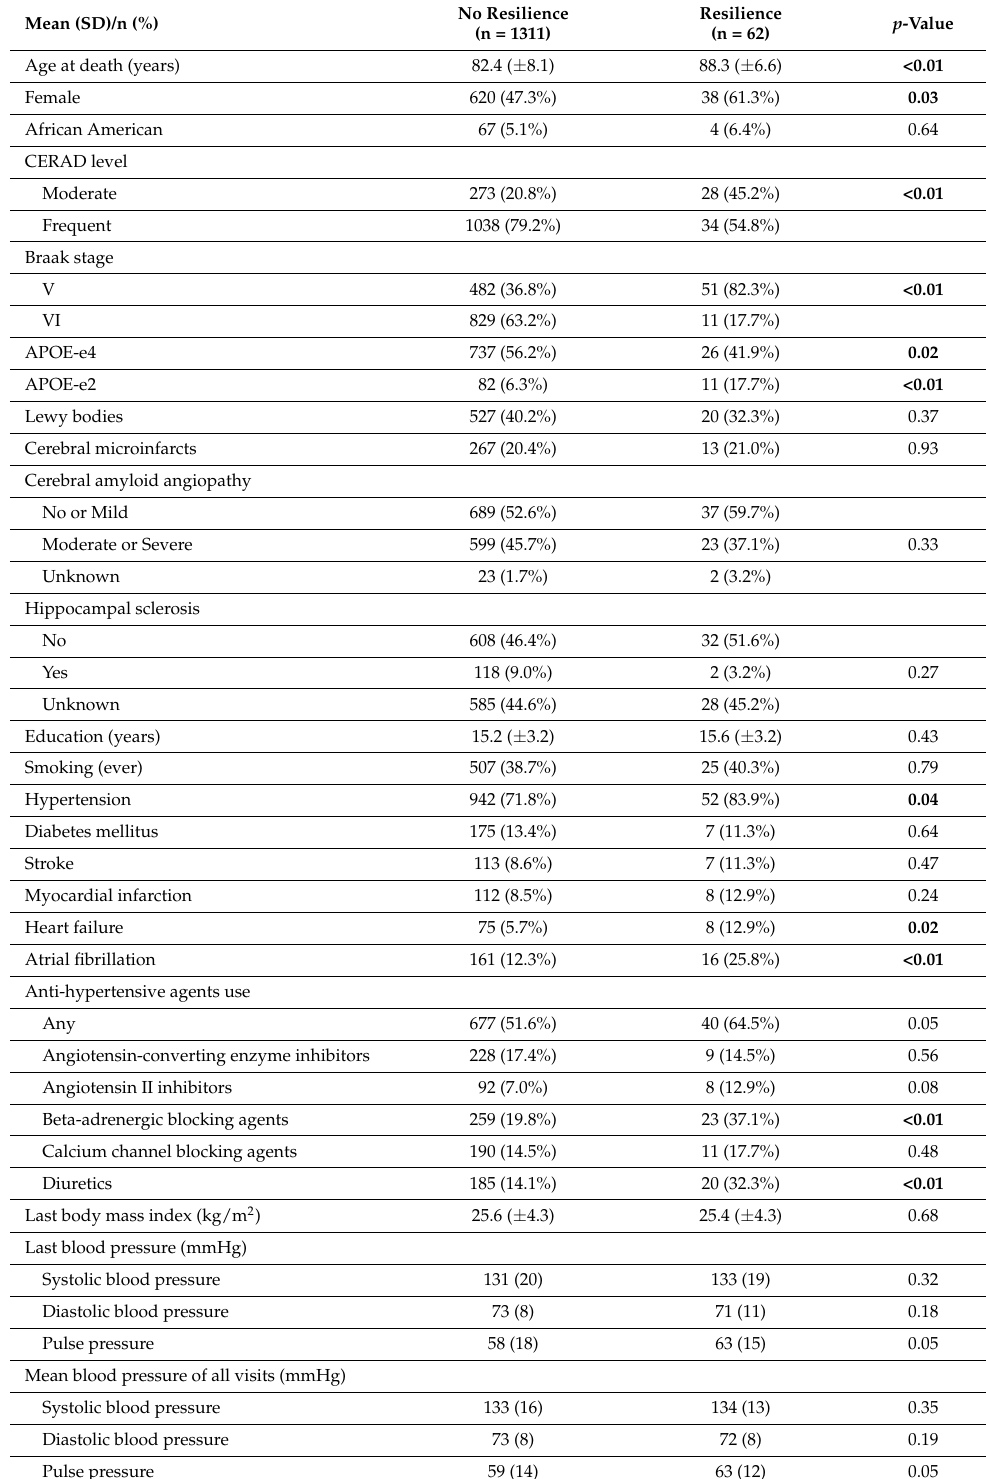
Table 1. Characteristics of 1373 participants in the National Alzheimer’s Coordinating Center (NACC) autopsy data, by resilience to Alzheimer’s disease